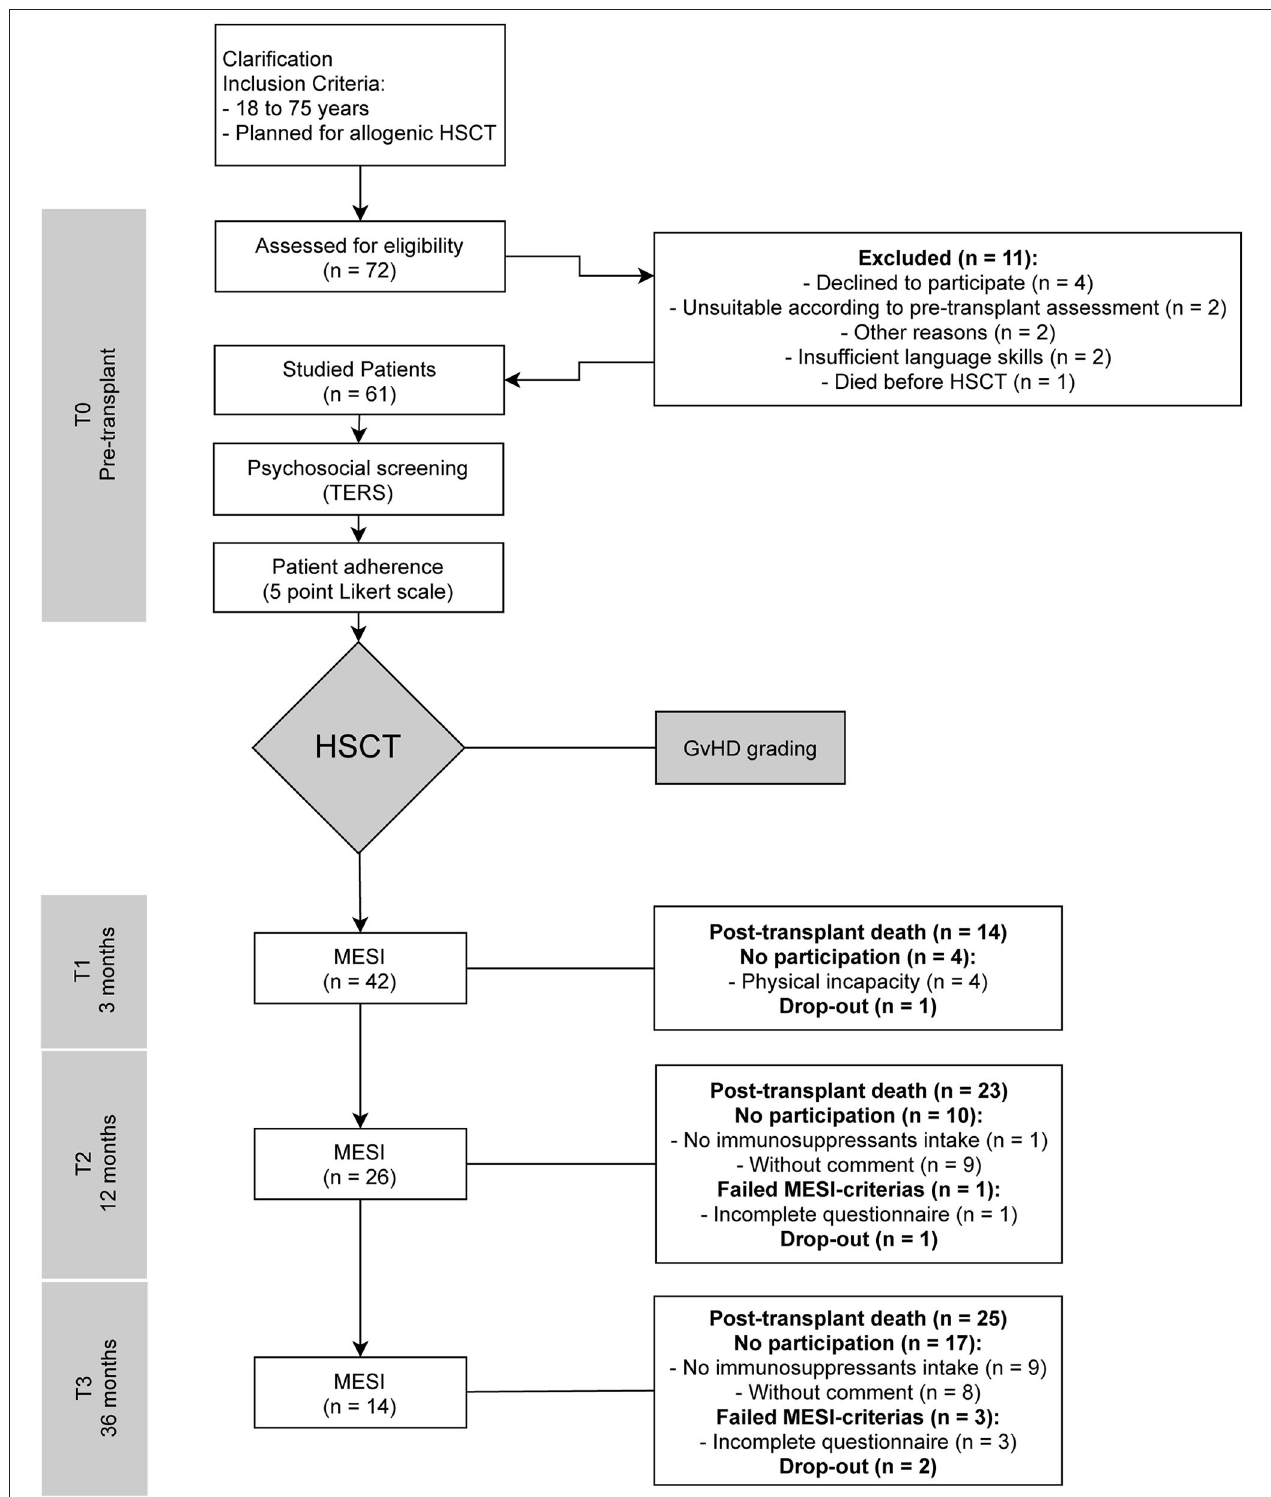
FIGURE 1 | Trial flow-chart. T0, pre-transplant; T1, three months post-transplant; T2, twelve months post-transplant; T3, 36 months post-transplant; HSCT, hematopoietic stem cell transplantations; TERS, Transplant Evaluation Rating Scale; SIRT, Structured Interview for Renal Transplantation; GvHD, graft-vs.-host disease; MESI, Medication Experience Scale for